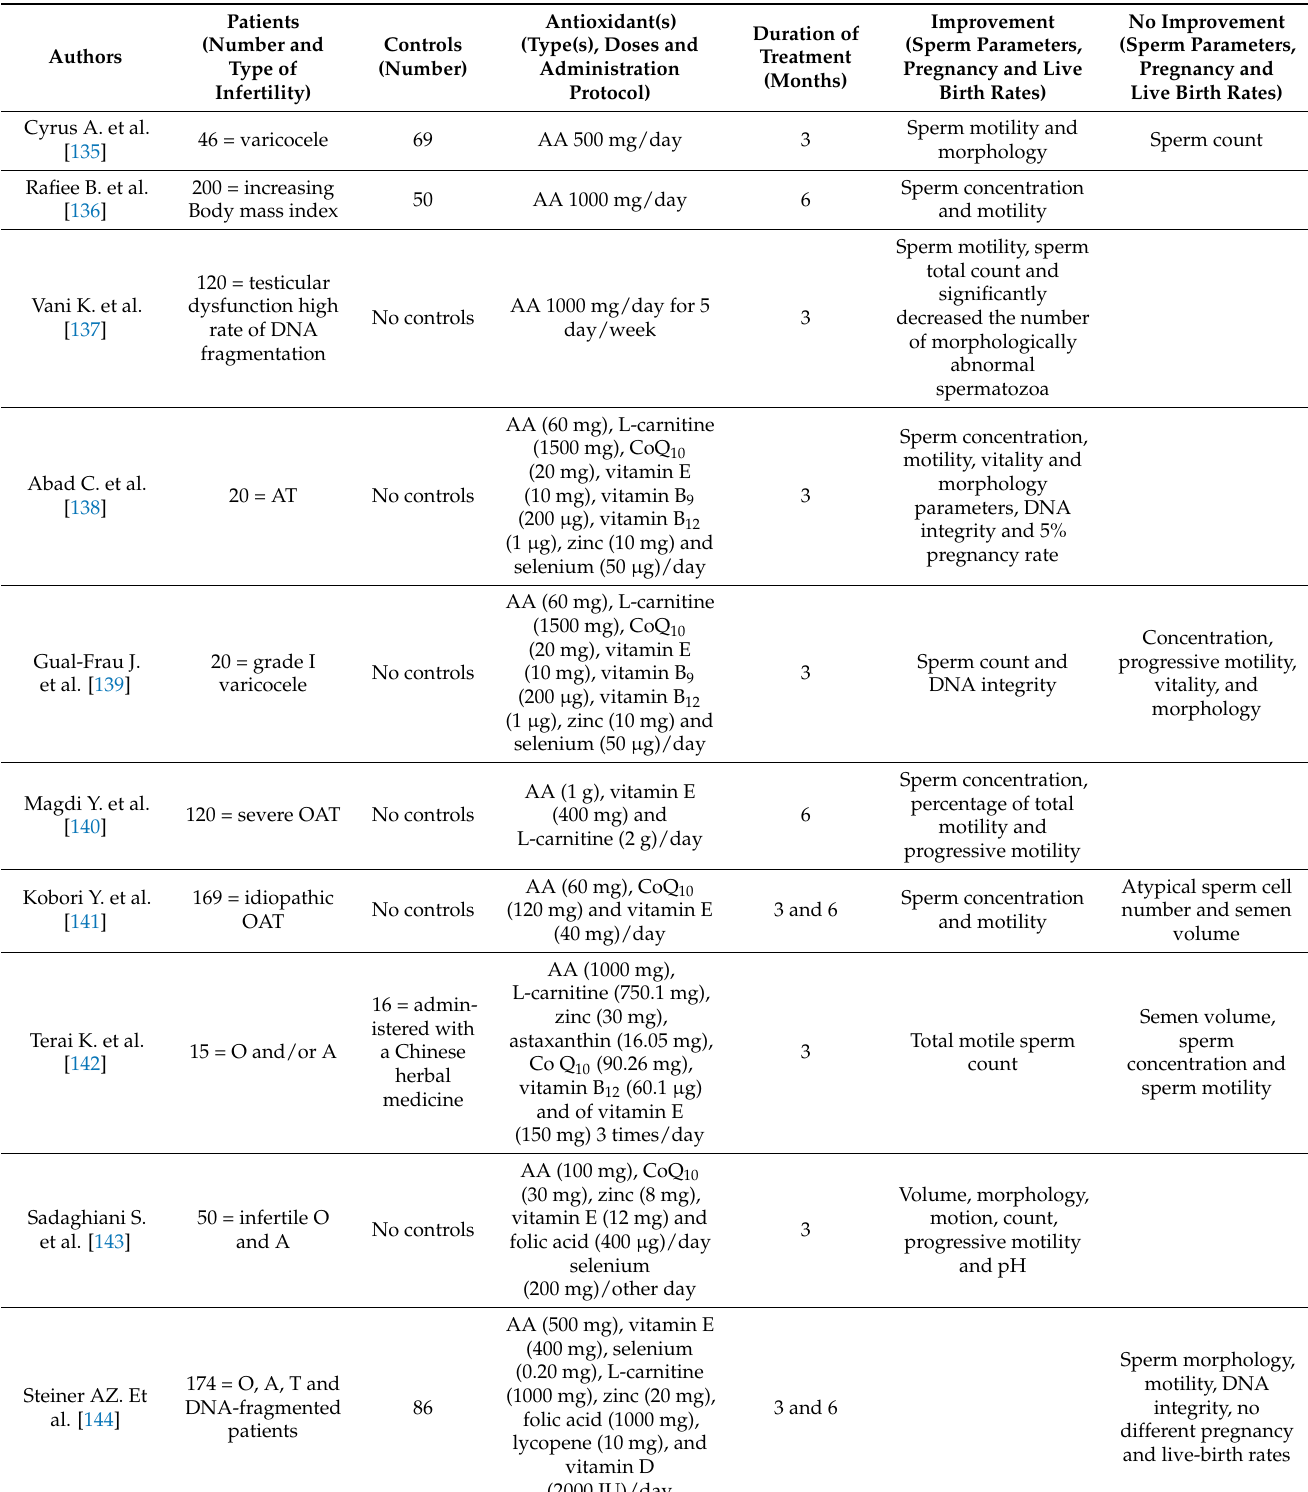
Table 1. Summary of the main results obtained in the 10 papers focusing on the effect of AA administration for the treatment of male